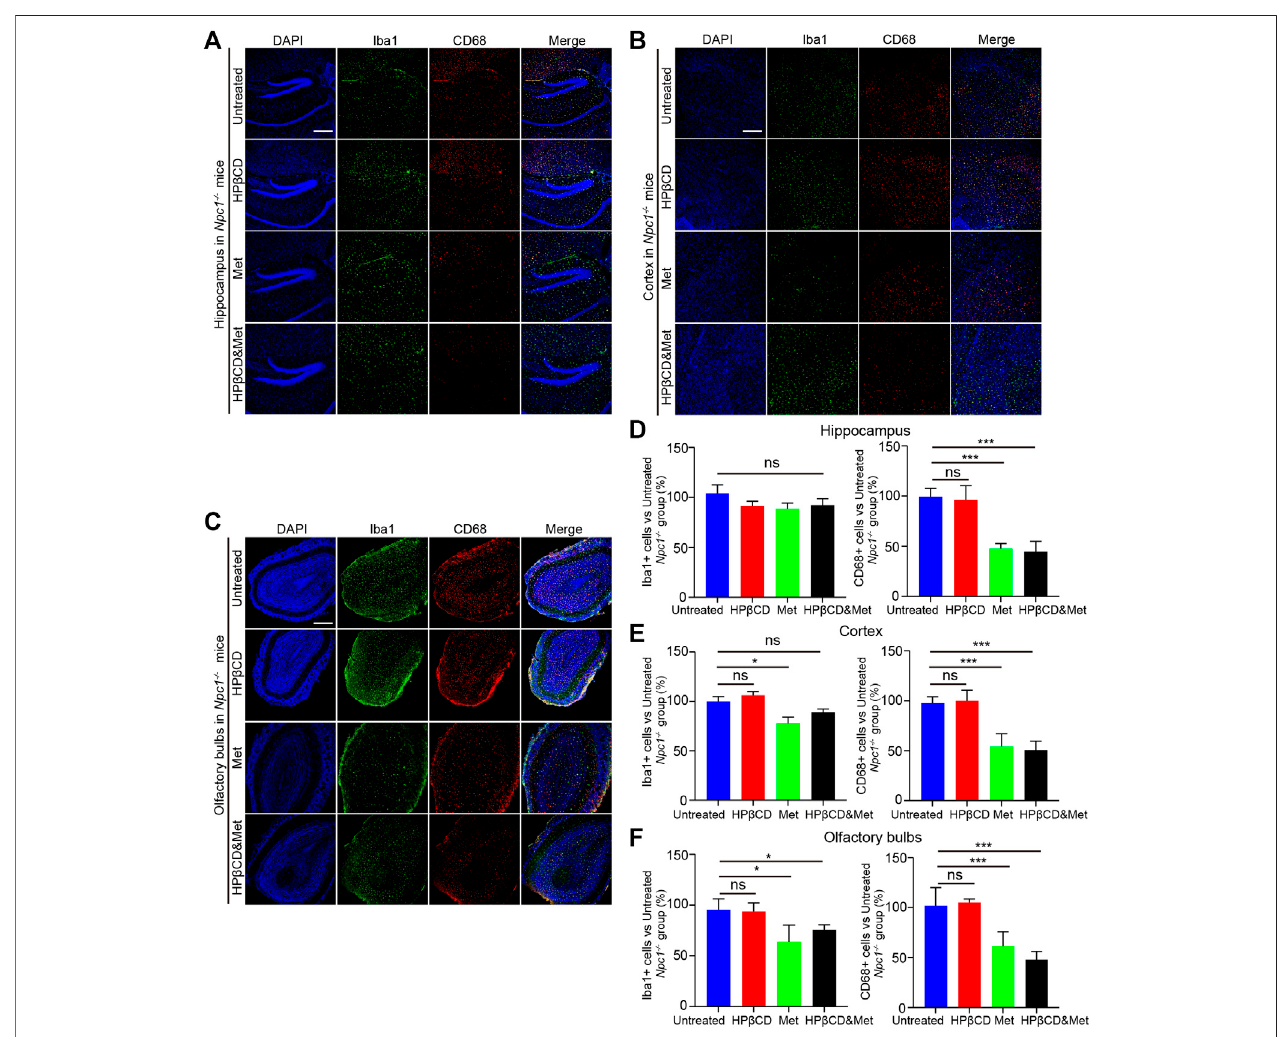
FIGURE 3 | Effects of test drugs on Iba1 and CD68 expression in Npc1 − / − brain. Representative images of Iba1 and CD68 expression in the hippocampus (A) , cerebralcortex (B) andolfactorybulb (C) intheindicatedgroups( n (cid:1) 4)(scalebar:100 μ m).QuantitativeanalysisofIba1andCD68positivecellsinthehippocampus (D) , cerebral cortex (E) and olfactory bulb (F) using ImageJ. Signi fi cant differences were detected by one-way ANOVA followed by Dunnett ’ s test, ns represents not signi fi cant, * p < 0.05, *** p < 0.001. versus untreated group.